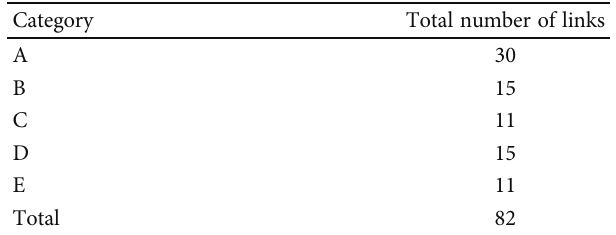
Table 1: Number of links gathered for each category.